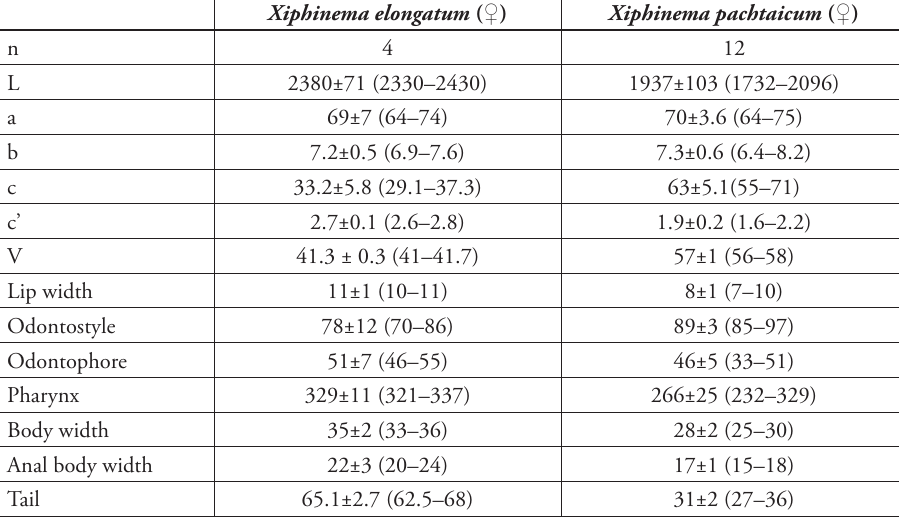
Table 2. Morphometric measurements of Xiphinema elongatum and Xiphinema pachtaicum. All measure- ments are in μ m, measurements presented as mean ± standard deviation